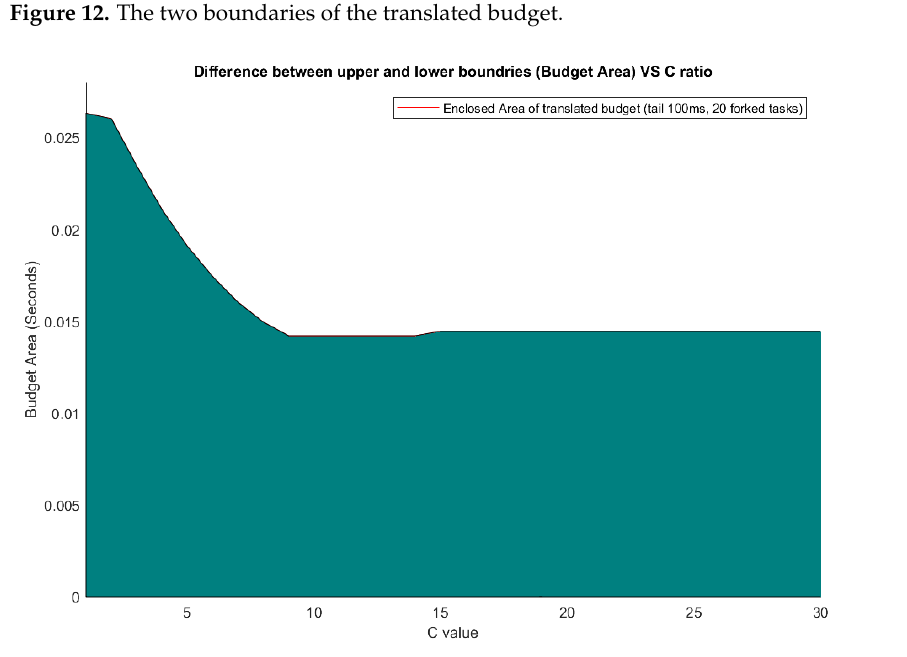
Figure 12. The two boundaries of the translated budget.